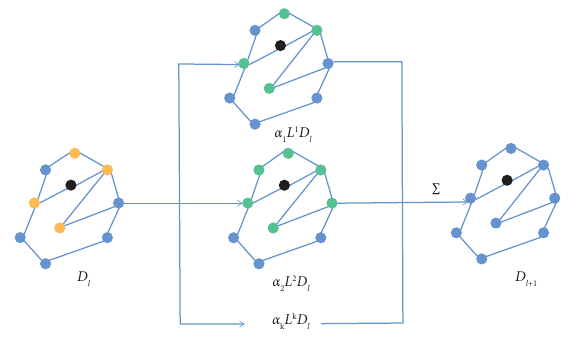
Figure 2: Graph convolution